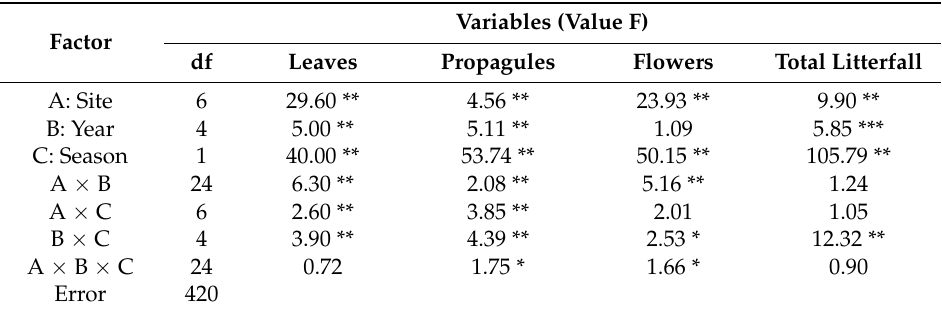
Table 5. Factorial ANOVA (three factors) ( A ) sites, ( B ) years, and ( C ) seasons for salinity for the litterfall components of Rhizophora mangle along the coast of Campeche (2009–2010 and 2014–2016).